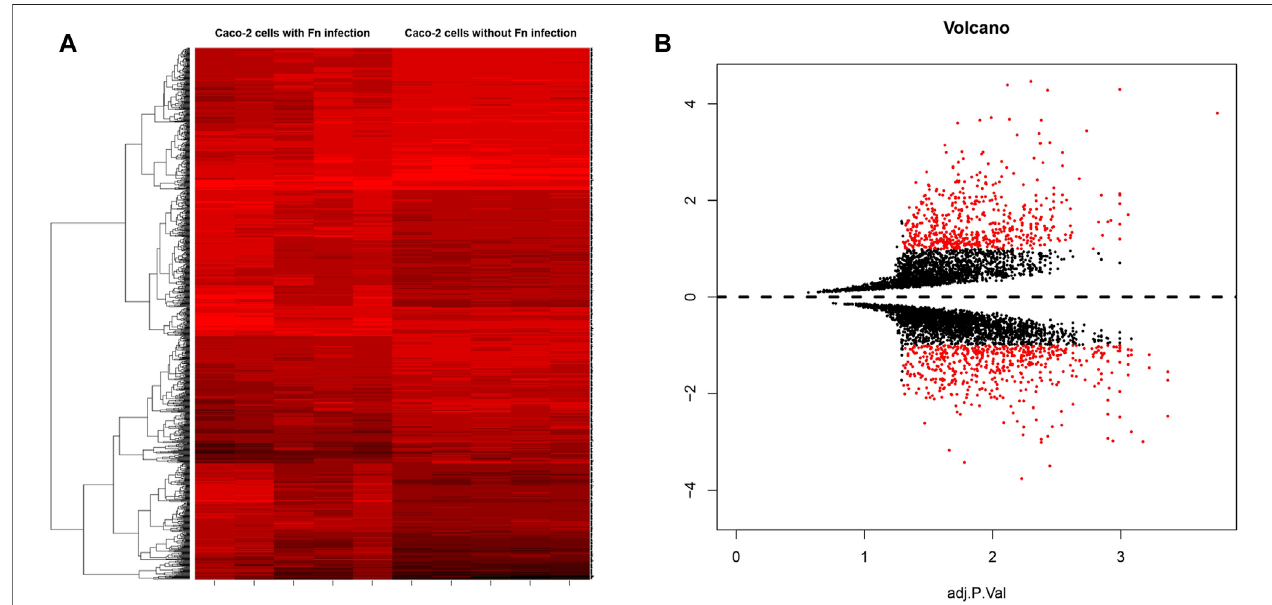
FIGURE 1 | (A) Heat map of DEGs. (B) Volcano plot of genes detected in Fn-positive and Fn-negative Caco-2 cells. Red means upregulated and downregulated DEGs; black means no difference.